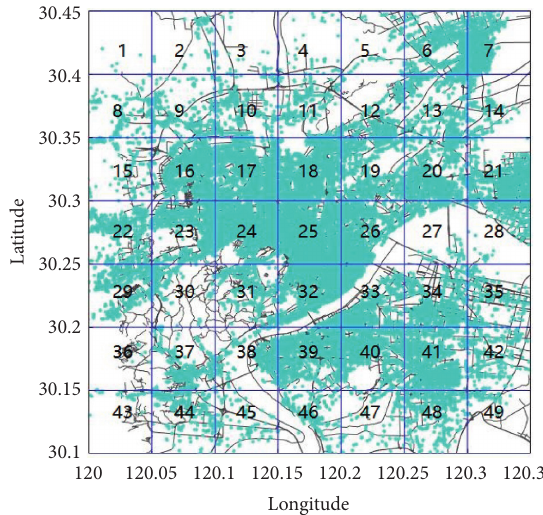
Figure 2: The spatial distribution of drivers and passengers’ ride requests in zones. (a) The number of registered drivers ( K (b) The number of requests in Hangzhou.